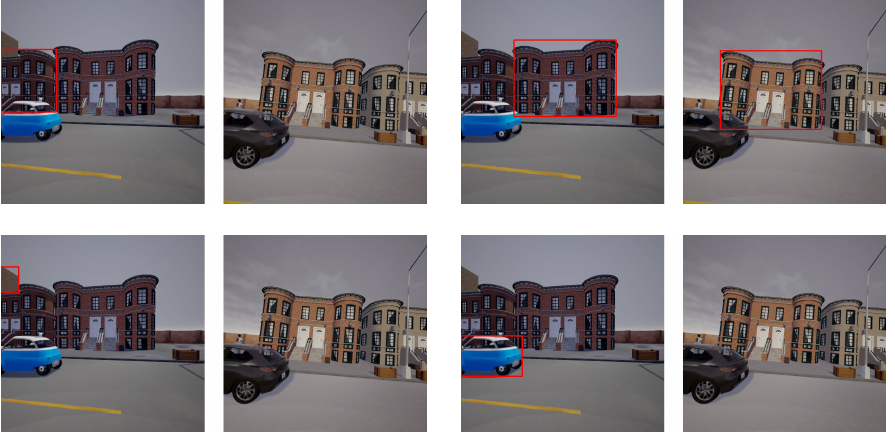
Figure 3. A visualization of the object pairs that were obtained by the graph matching module. The red boxes highlight the object in I 1 and the corresponding object in I 2 . When there was no corresponding object, no red boxes are